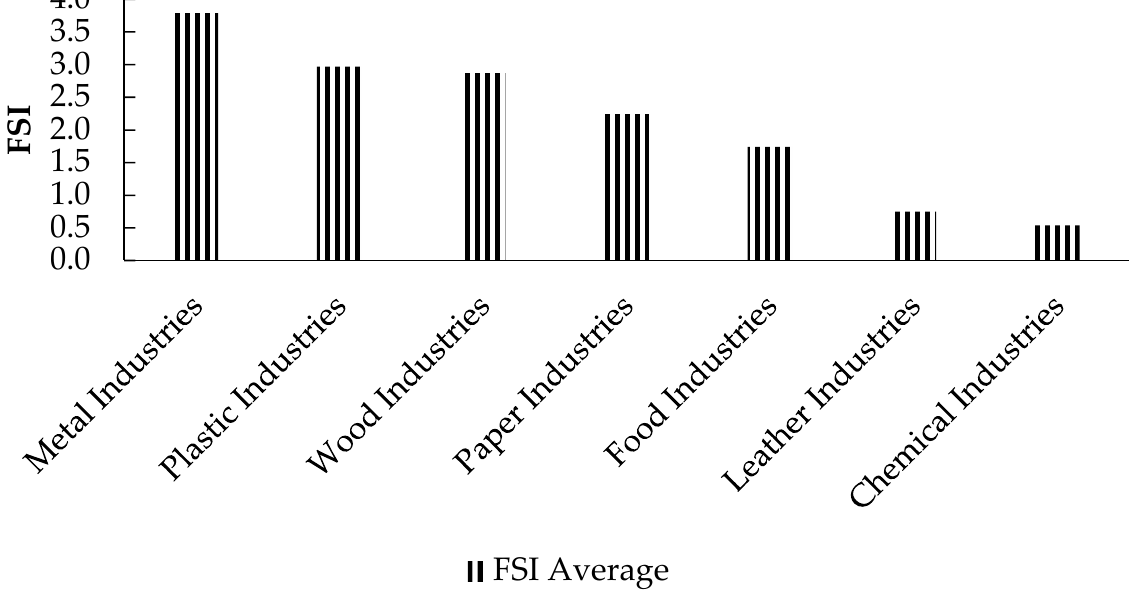
Figure 16. The severity classification of the Palestinian industrial sectors according to the FSI indicator.